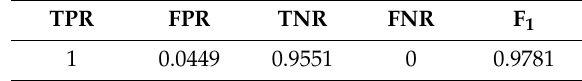
Figure 6. The AMoF and the fitted slope for different nodes for scenario NS15P7: ( a ) The AMoF for different NUT; ( b ) the fitted slope for NS15P7_BH_GM 25/5. Table 6. Performance characterization for NS15P7_BH_GM 25/5.